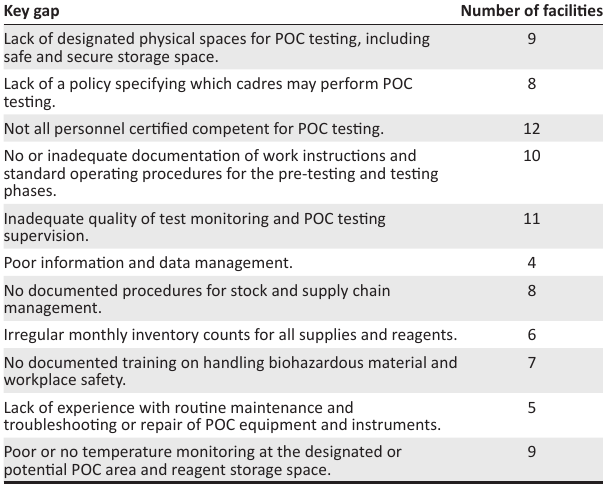
TABLE 3: Common gaps identified during the site capacity assessments of health facilities ( N = 15) in Lesotho, 2016. Key gap Number of facilities